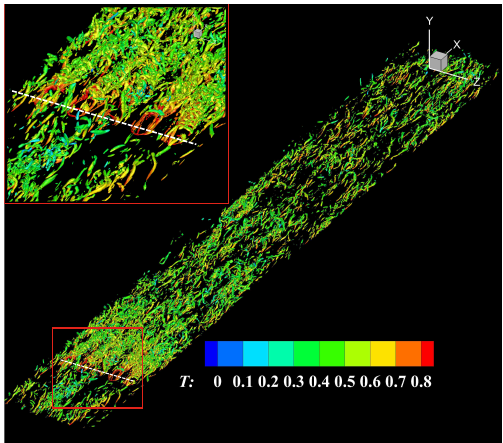
Figure 7. λ 2 contours colored with instantaneous temperature. The inset is a zoomed-in view of the flow field near the jets. The dashed white line shows the centerline of the jets. The iso-surfaces are drawn for λ 2 = − 3.